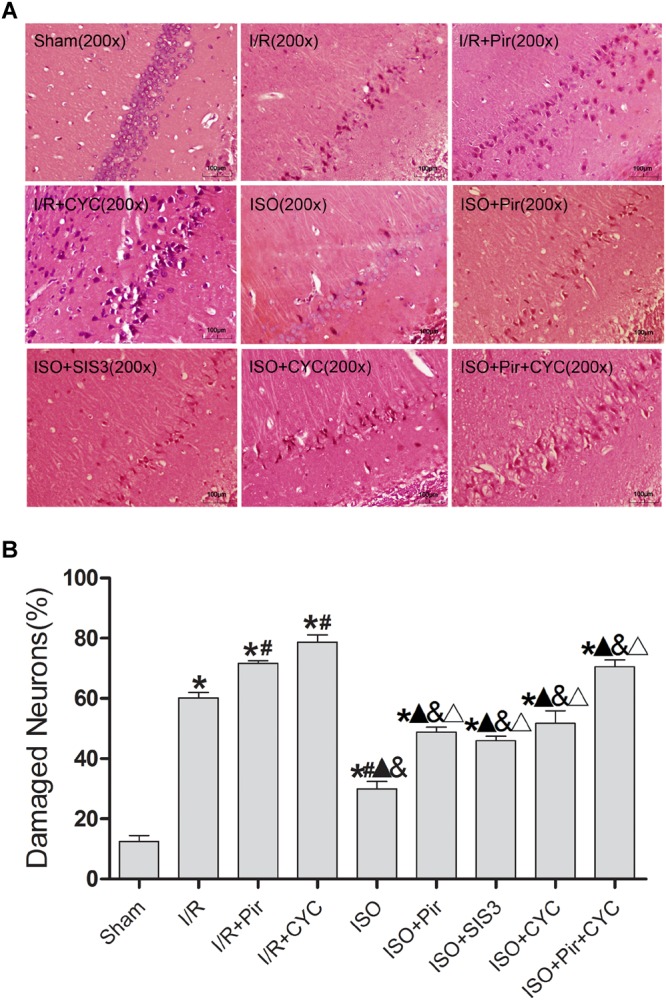
ISO post-conditioning decreased the damaged pyramidal neurons in the hippocampal CA1 region. (A) showed the morphology of CA1 region neurons by HE staining (B) showed the percentage of damaged neurons. Scale bars = 100 μm. Data are shown as the mean ± SD (n = 3). ∗
P < 0.05 vs. Sham; # P < 0.05 vs. I/R;
P < 0.05 vs. I/R + Pir; & P < 0.05 vs. I/R + CYC; Δ P < 0.05 vs. ISO.